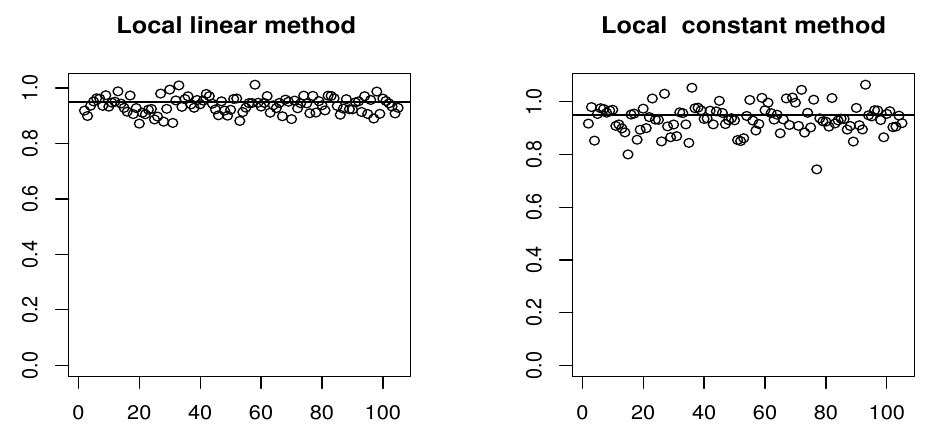
Figure 5. The PC of LLM (on the left ) and the PC of LCM (on the right